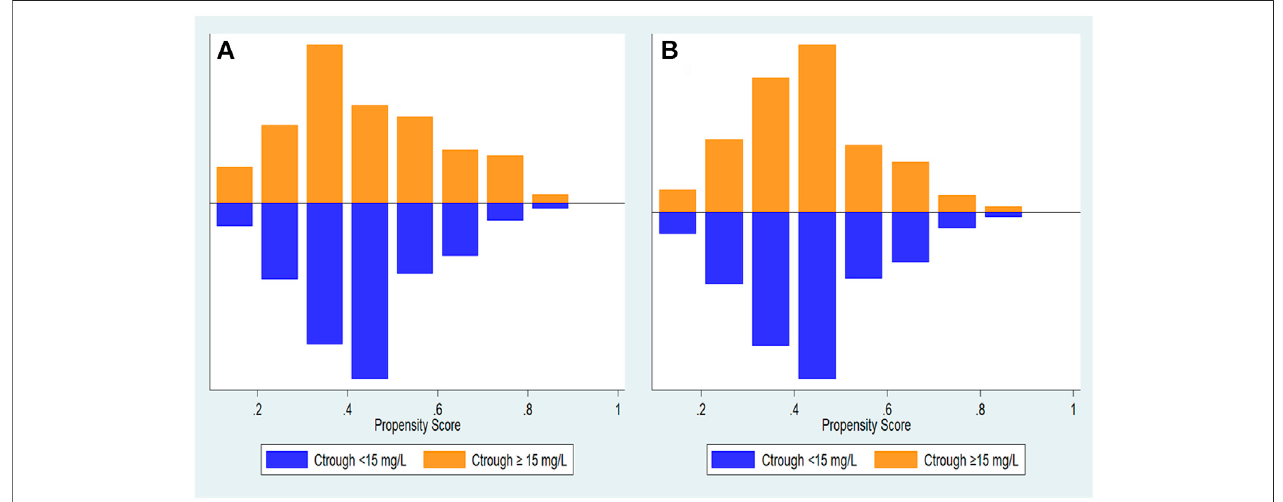
FIGURE 2 | Distribution of propensity scores. (A) propensity score before matching and (B) propensity score after matching.